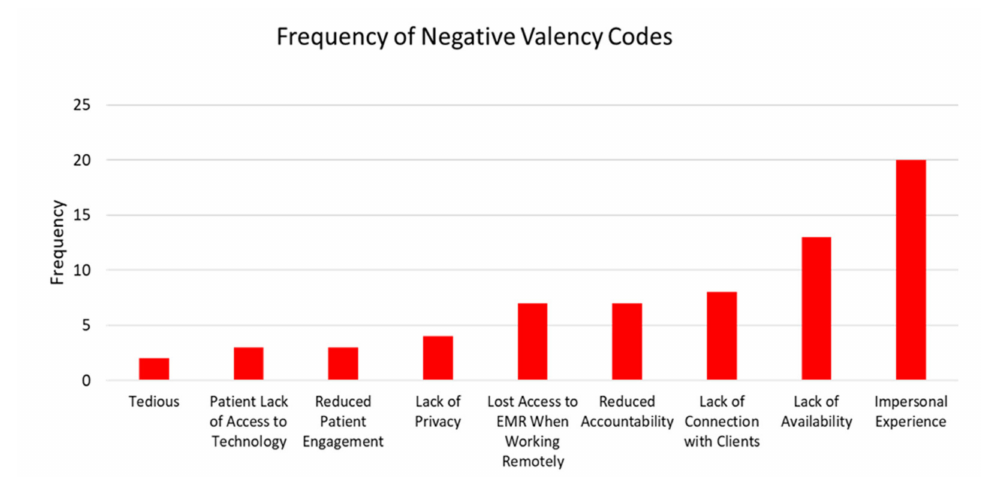
Figure 2. Frequency of negative valency